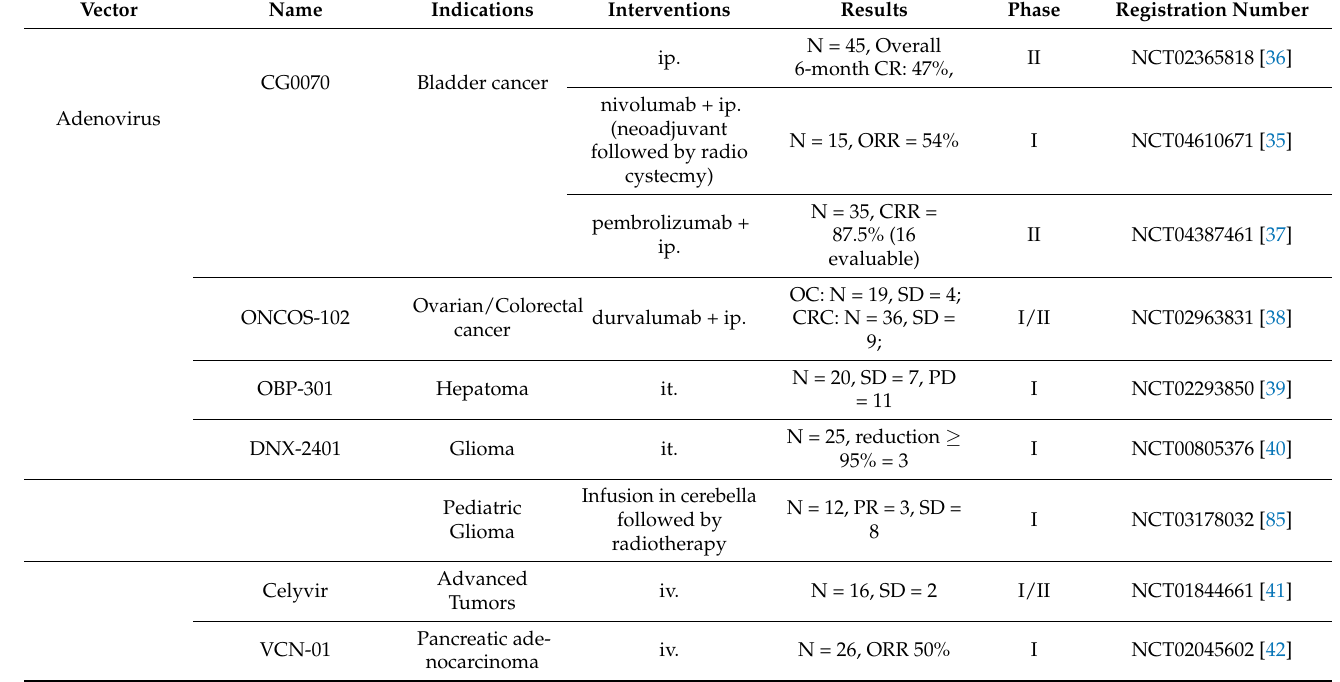
Table 1. Overview of clinical trials with promising results of oncolytic viruses from